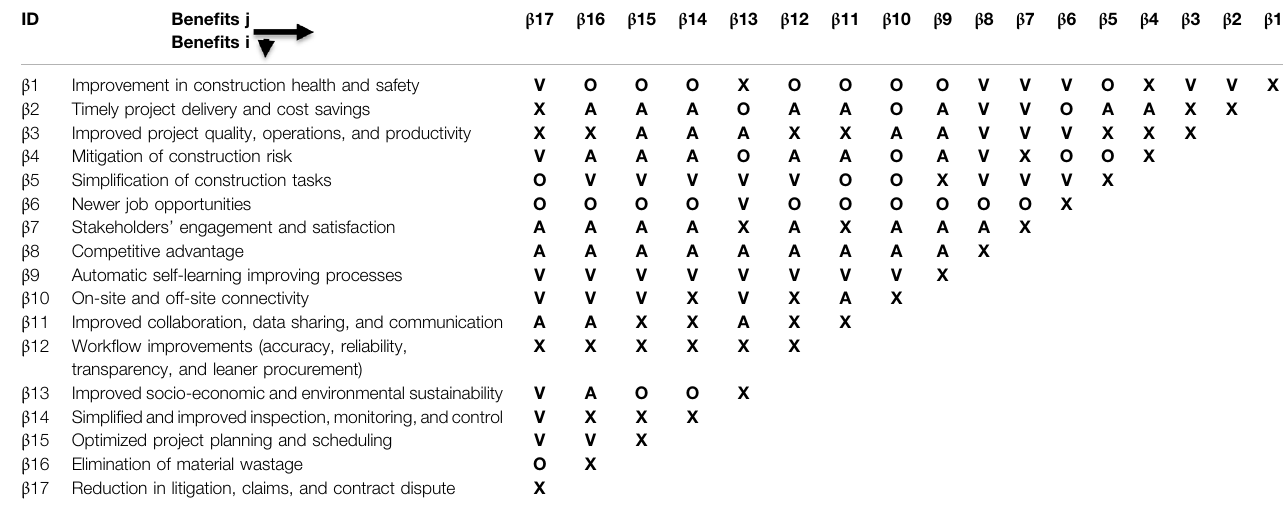
TABLE 4 | SSIM for bene fi ts of automation and arti fi cial intelligence.